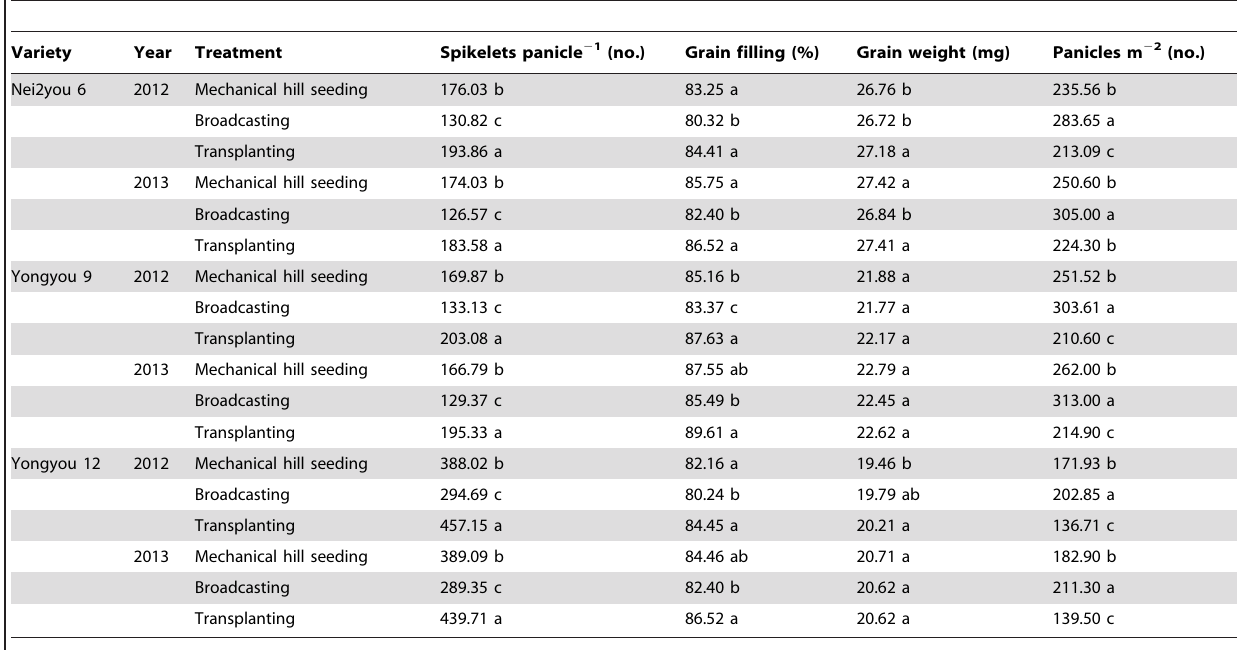
Table 4. Grain yield components of three high-yielding hybrid varieties under three plant establishment methods in Fuyang and Yuhang, Zhejiang Province, China, in 2012 and 2013.